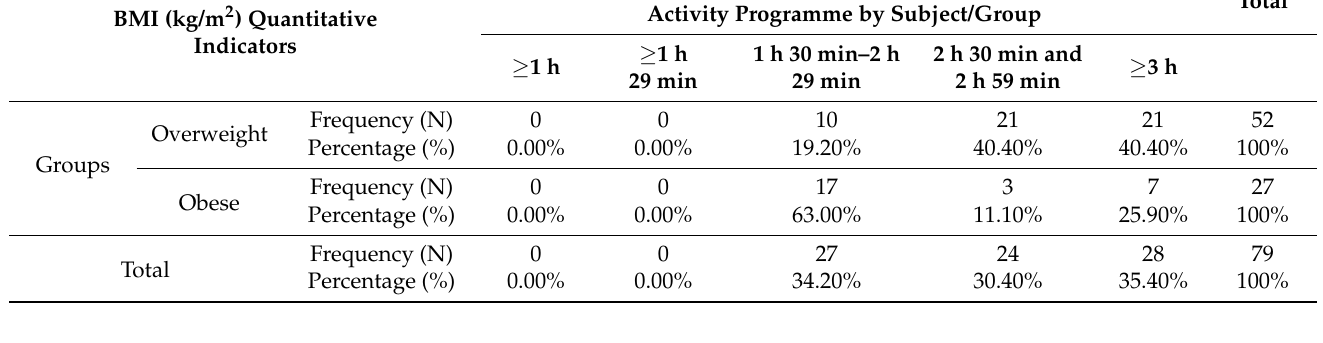
Table 6. Distribution of total weekly time spent on physical activity by weight group and time interval.